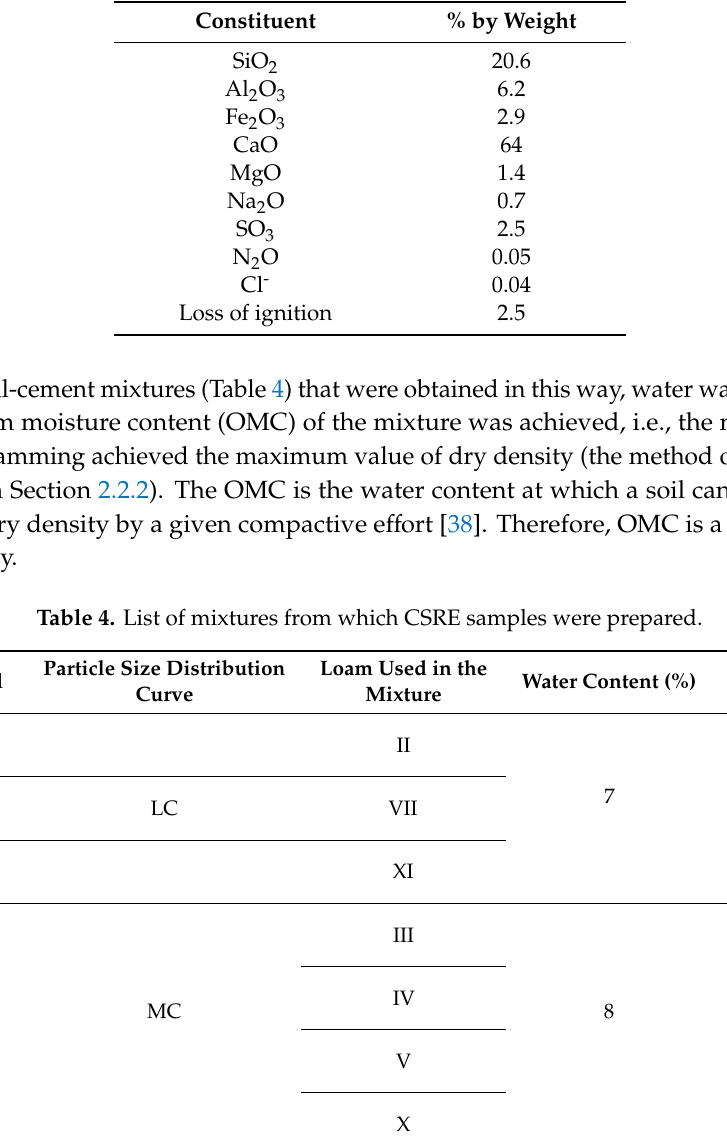
Table 3. Chemical composition of Portland Cement CEM I 42.5 R.